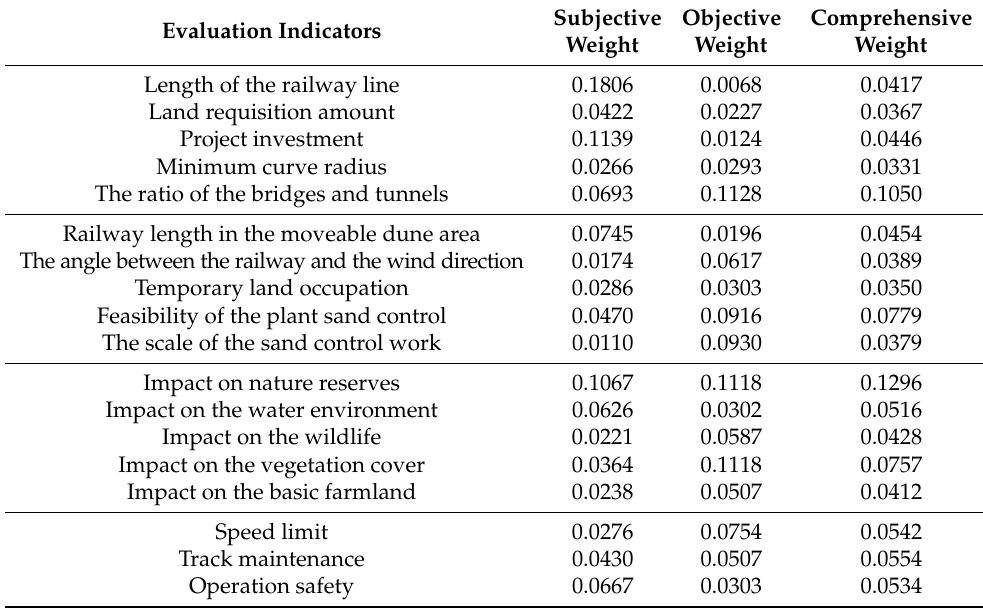
Table 5. The weights of evaluation